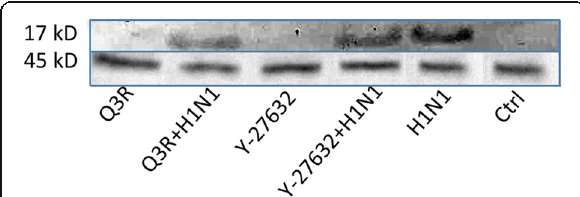
Fig. 2 Modulation of the RhoA protein expression. MDCK cells were treated with Q3R and Y-27632 in the presence or absence of H1N1 for 48 h. The blot is typical of two independent experiments with similar results. Each blot was scanned and imaged separately